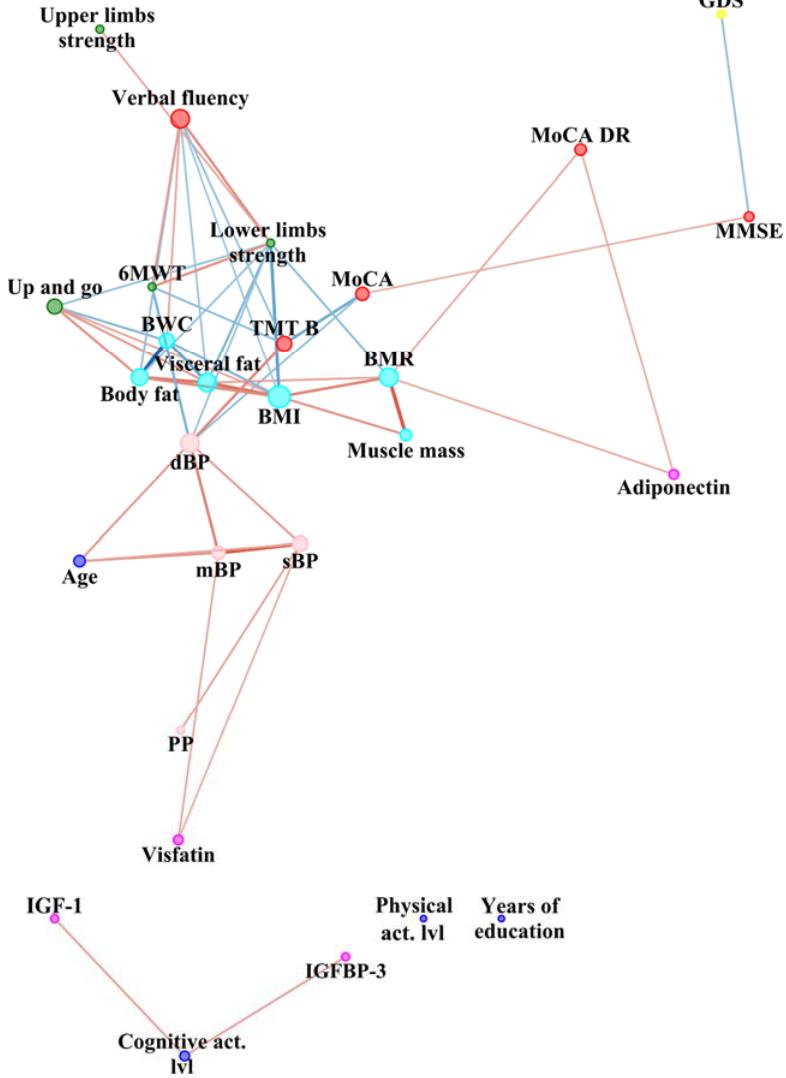
Figure 3. Network analysis in NTN group. sBP—systolic blood pressure, dBP—diastolic blood pressure, mBP—mean blood pressure, PP—pulse pressure, MMSE—Mini–Mental State